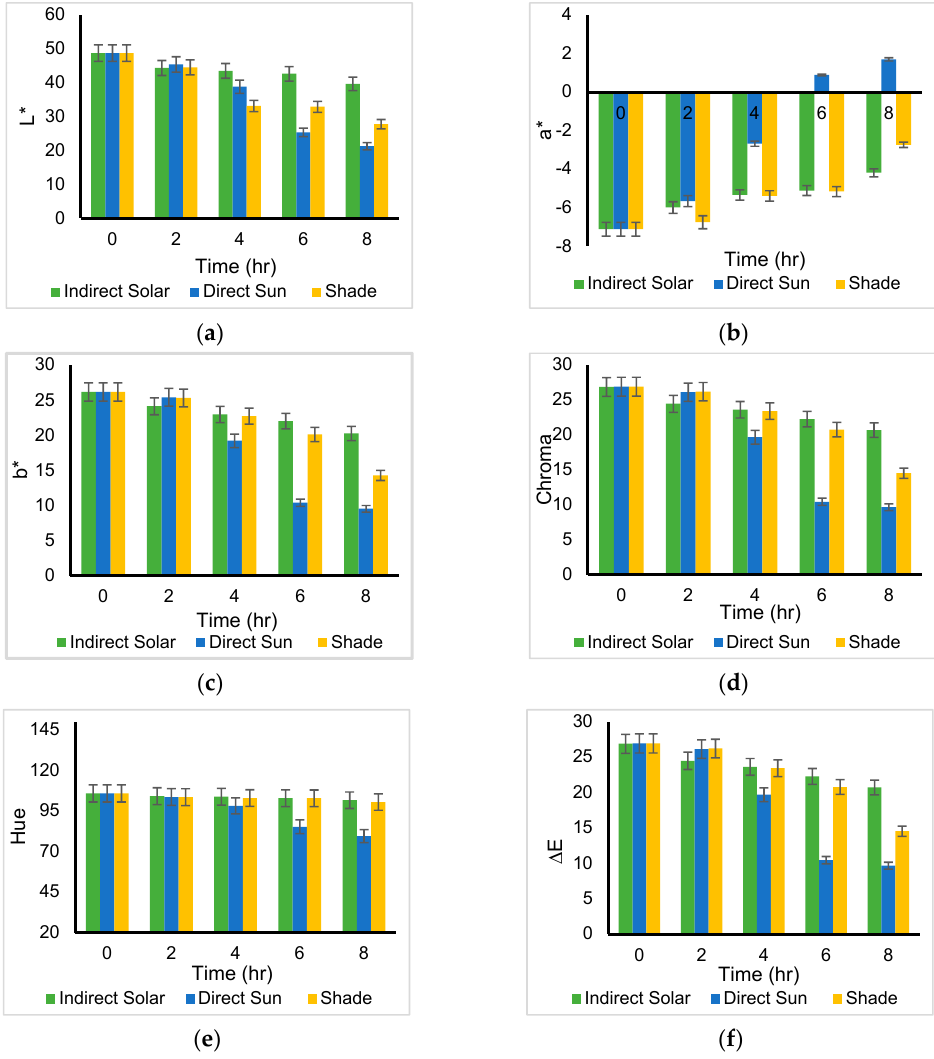
Figure 7. Comparison of Basil color parameters by drying method in summer season: (( a ) L*: Lightness, ( b ) a*: (+) redness/( − ) greenness, ( c ) b*: (+) yellowness/( − ) blueness, ( d ) Chroma, ( e ) Hue, and ( f ) color difference) degradation during indirect solar ‐ drying ( n = 3).